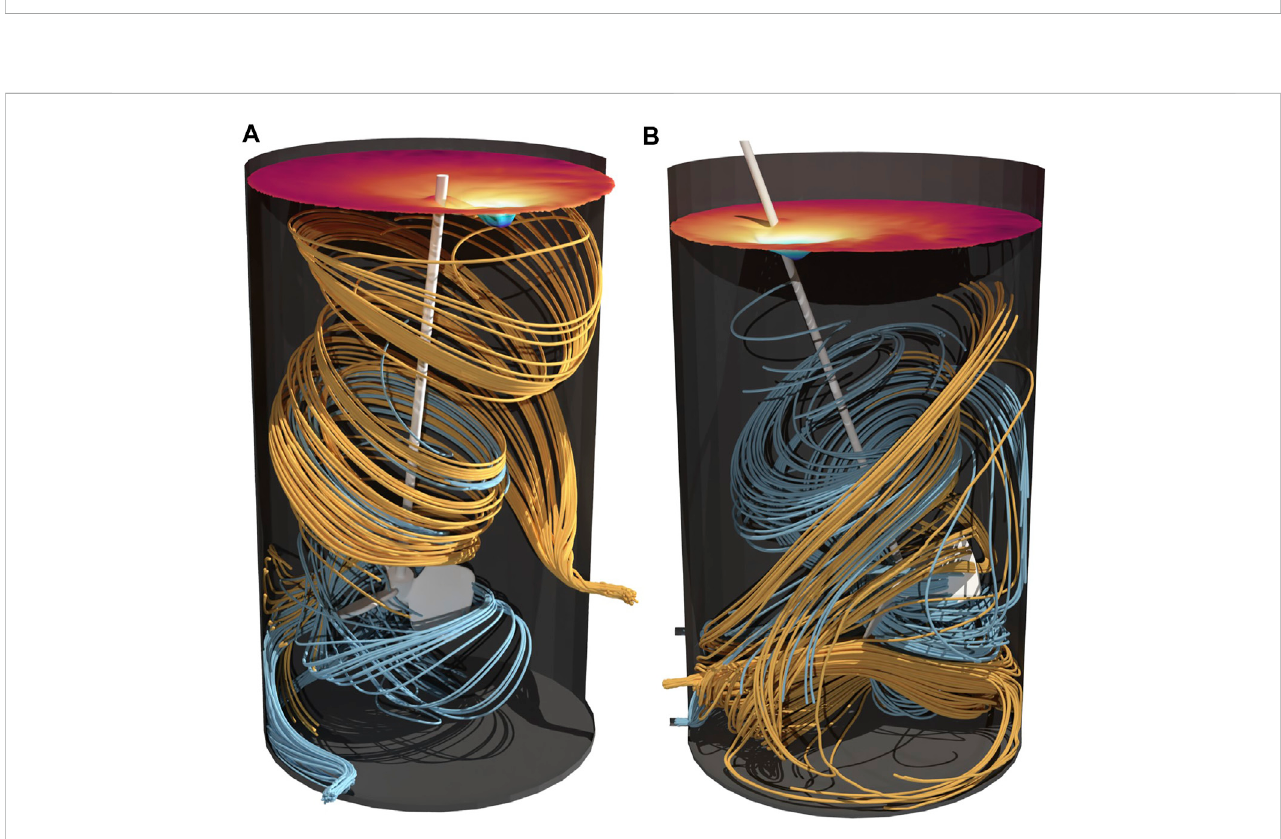
FIGURE 6 Streamlines in 100 L (A) and 500 L (B) perfusion bioreactor. Streamlines calculated forwardsinorangeas in fl owand streamlinescalculated backwards in blue as out fl ow. The surface color indicates the topology of the